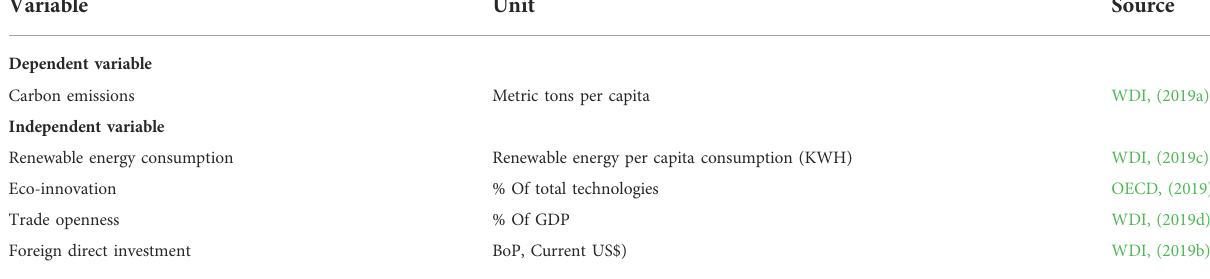
TABLE 1 Description of variables utilized in the